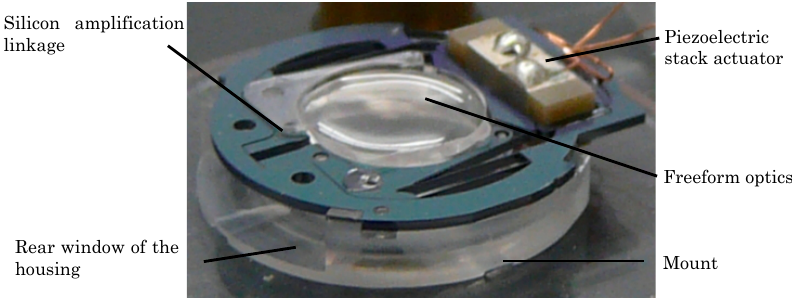
Figure 8. Optical micromachine assembled to the rear half shell of the glass housing.